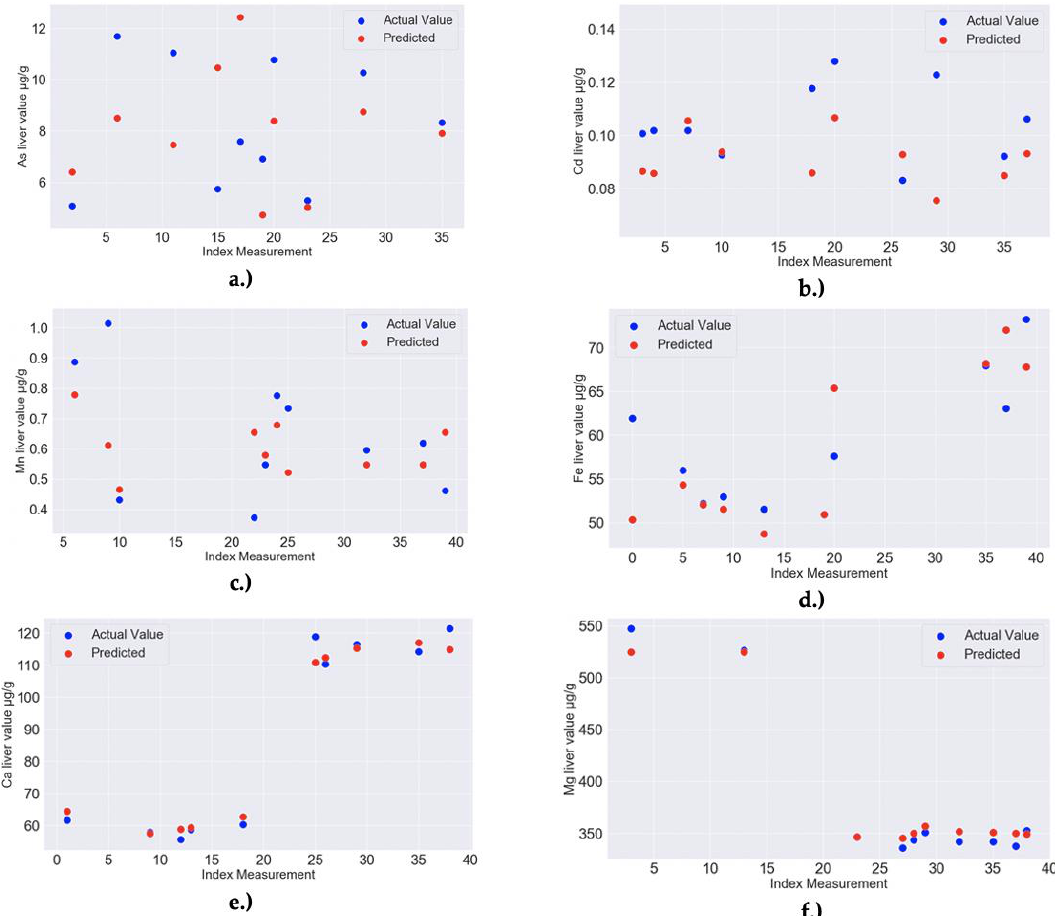
Figure A2. Prediction of heavy metal concentration for turbot liver tissues—actual values vs. predicted value for first group non-linear tree-based RF prediction models, described in Section 2.2.2. (( a ). prediction for As concentration; ( b ). prediction for Cd concentration; ( c ). prediction for Mn concentration; ( d ). prediction for Fe concentration; ( e ). prediction for Ca concentration; ( f ). prediction for Mg concentration).